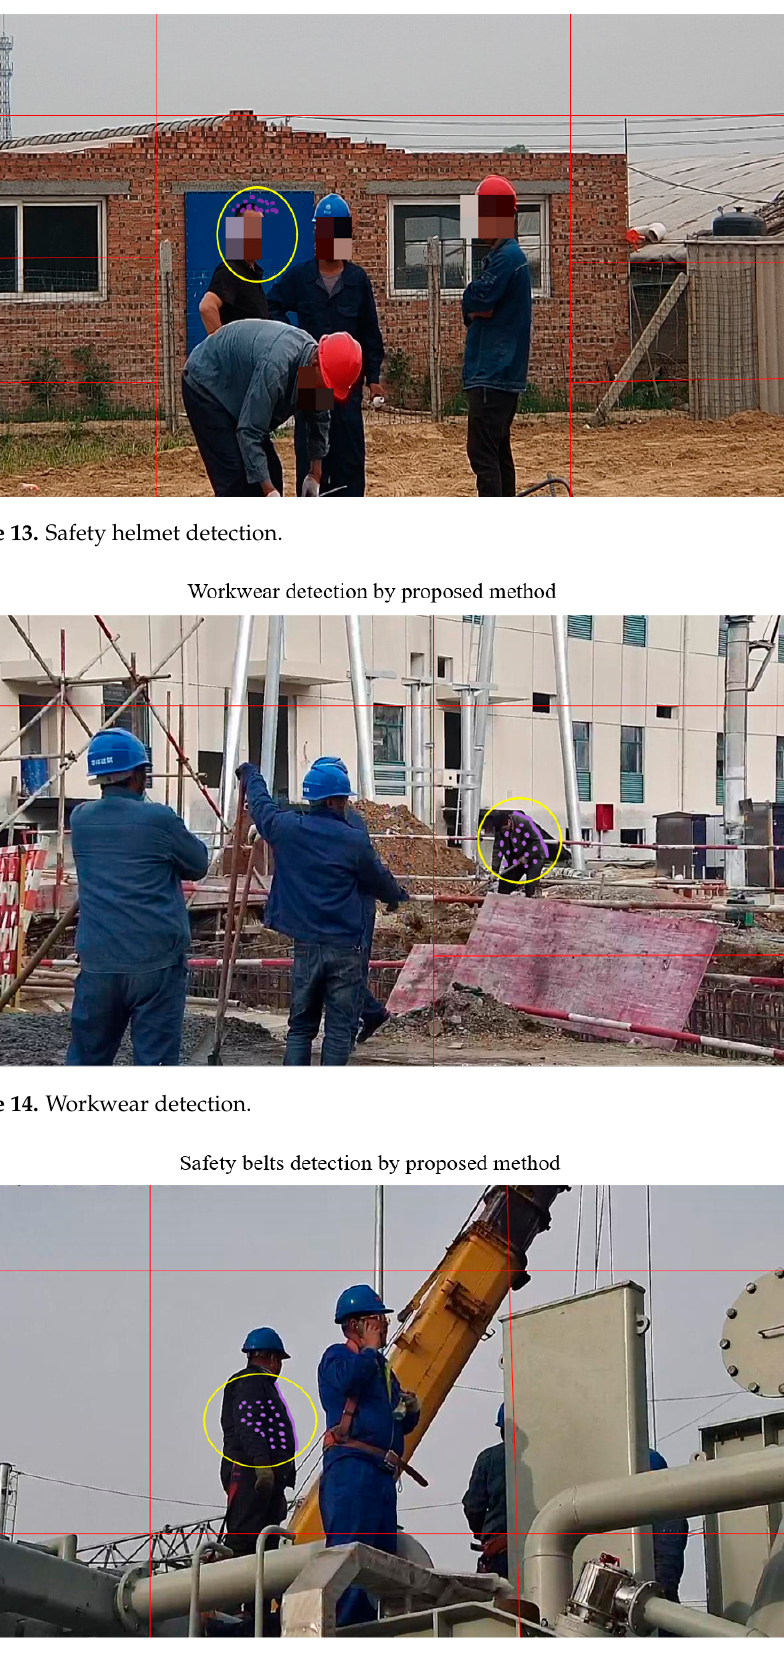
Figure 15. Safety belt detection.